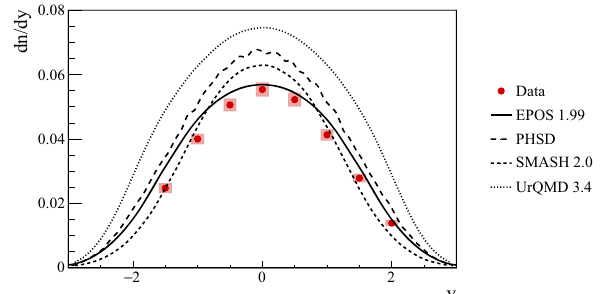
Fig. 12 Comparison of the results on the K 0 rapidity distribution with S predictions of theoretical models. Coloured red circles show the new measurements of NA61/SHINE. The black curves show predictions of models: EPOS 1.99 (solid), PHSD (long dashed), SMASH 2.0 (short dashed) and UrQMD 3.4